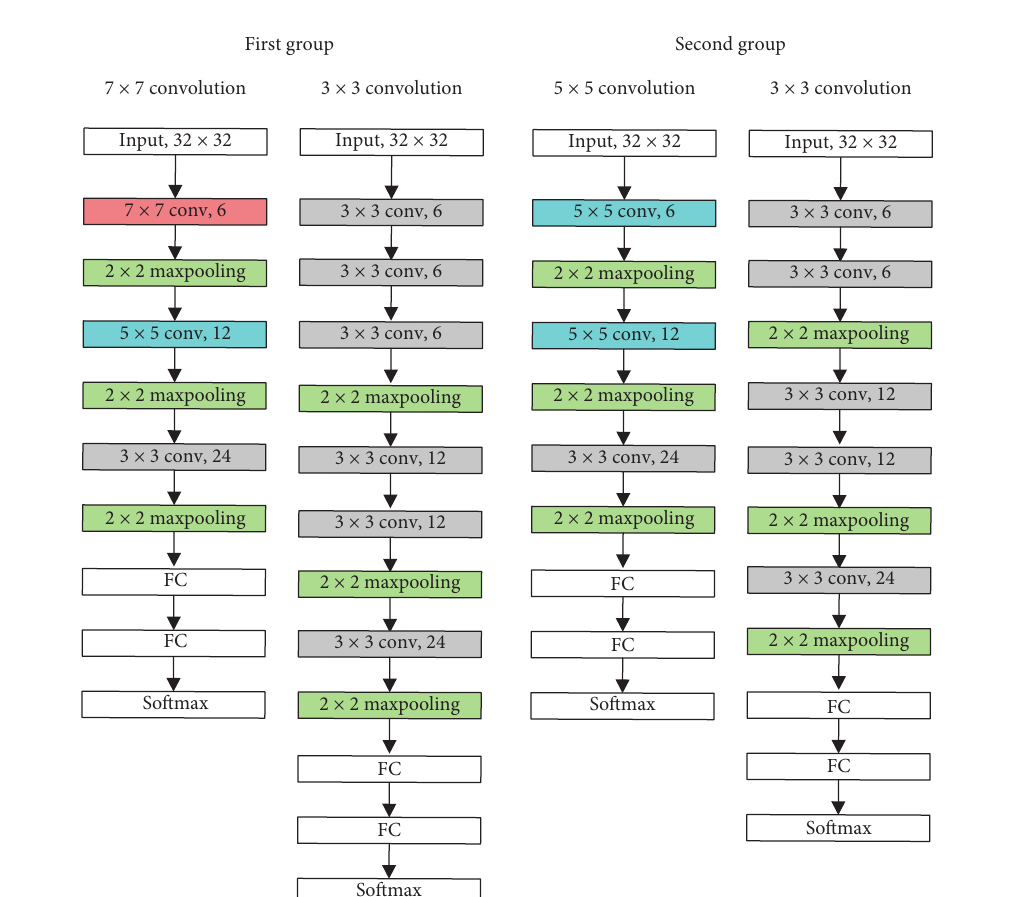
Figure 3: Network structure of small convolutional kernel experiment.